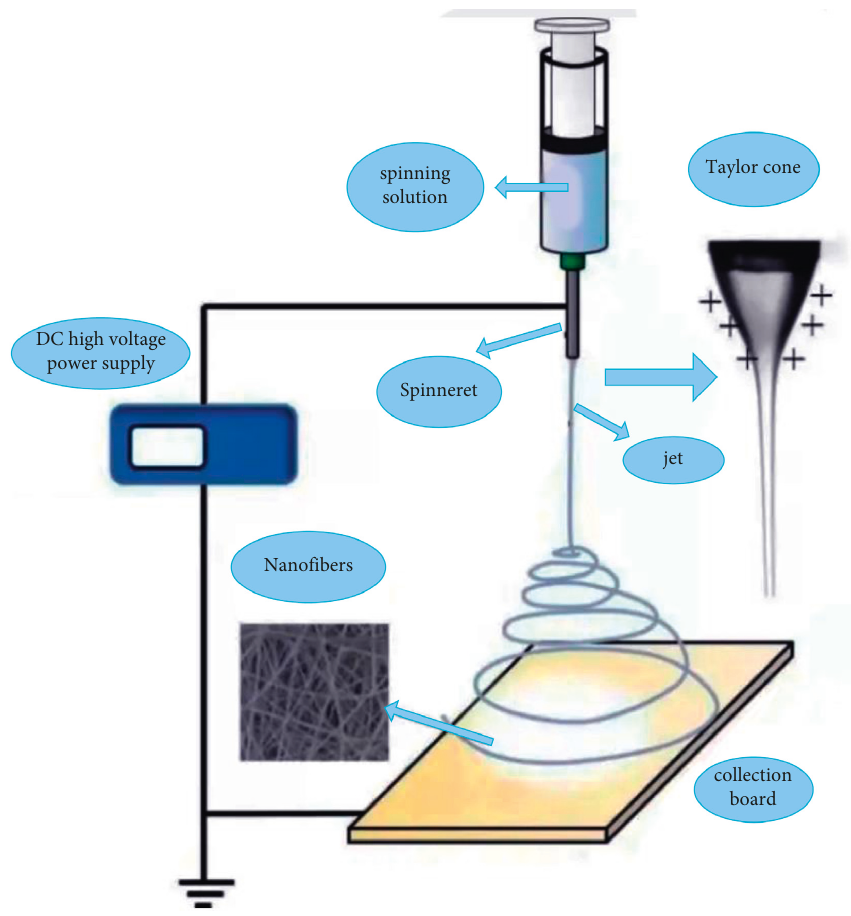
Figure 6: Schematic diagram of electrospinning experimental